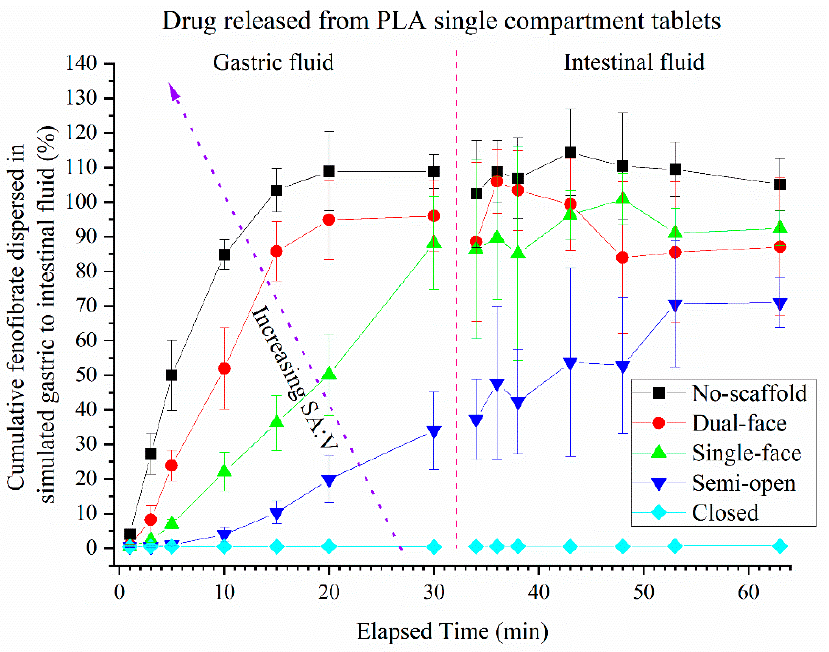
Figure 9. Effect of exposed surface area on release of FEN from different single-compartment PLA-based scaffolds containing fenofibrate-loaded SMEDDS measured by HPLC (error bars = AVG ± SD, n = 3, with exception of no-scaffold series whereby n =6). The dashed red line indicates the dispersant transition period.